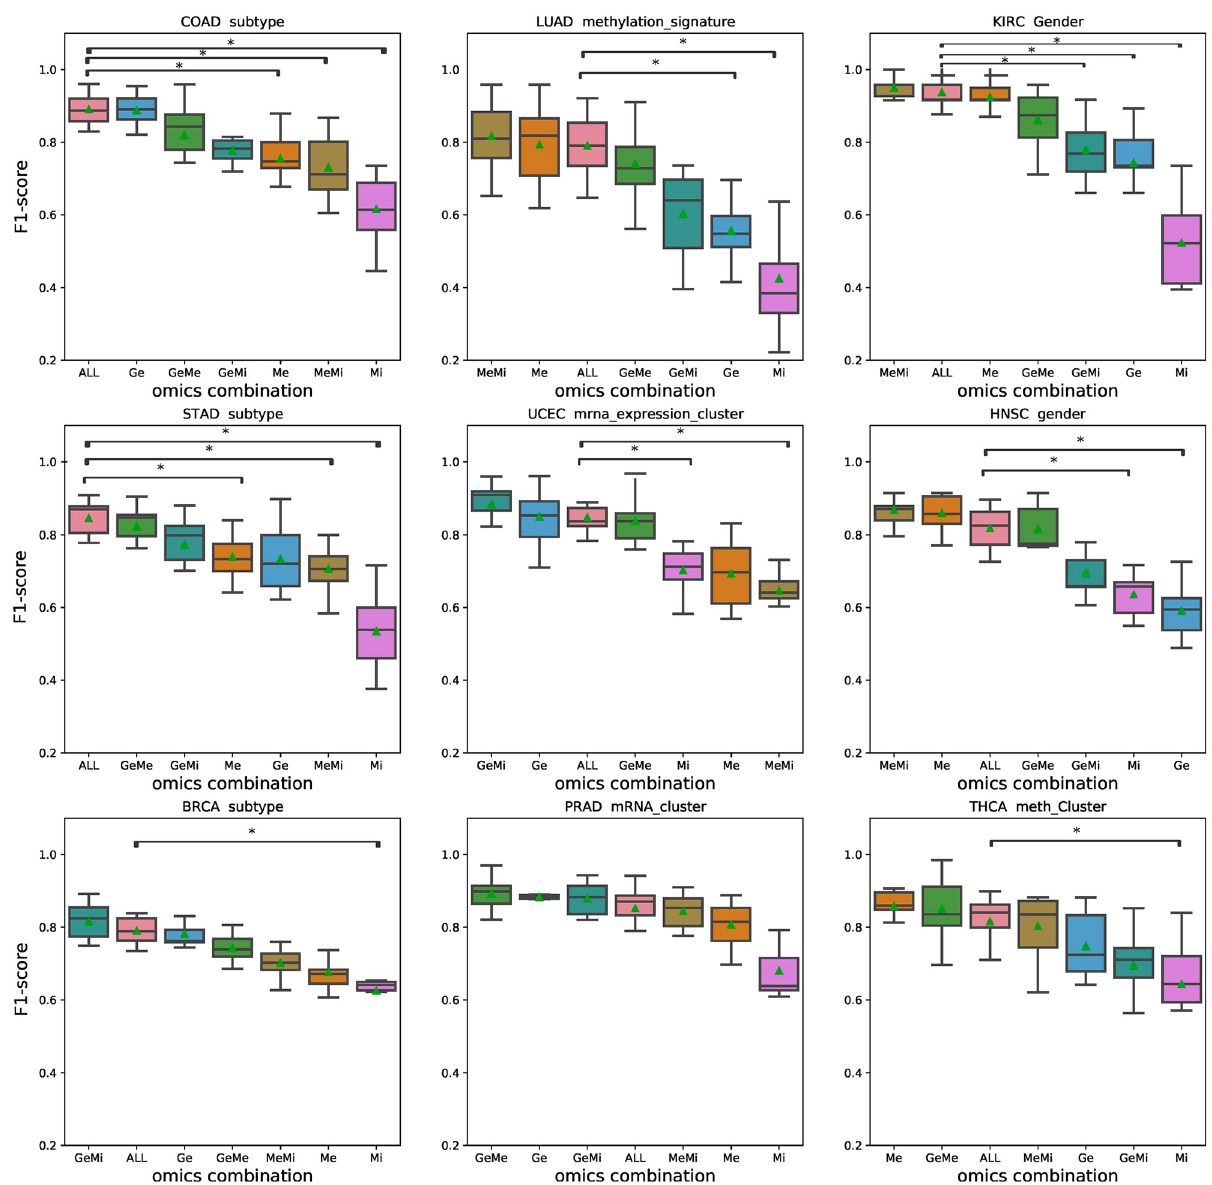
Fig 6. The comparison of omics combination. For each cancer type, the F1 score was measured on the clinical feature with best classification accuracy by utilizing different sets of omics combinations. ‘ALL’ indicates the combination where all three omics were used. Overall, ‘ALL’ showed robust